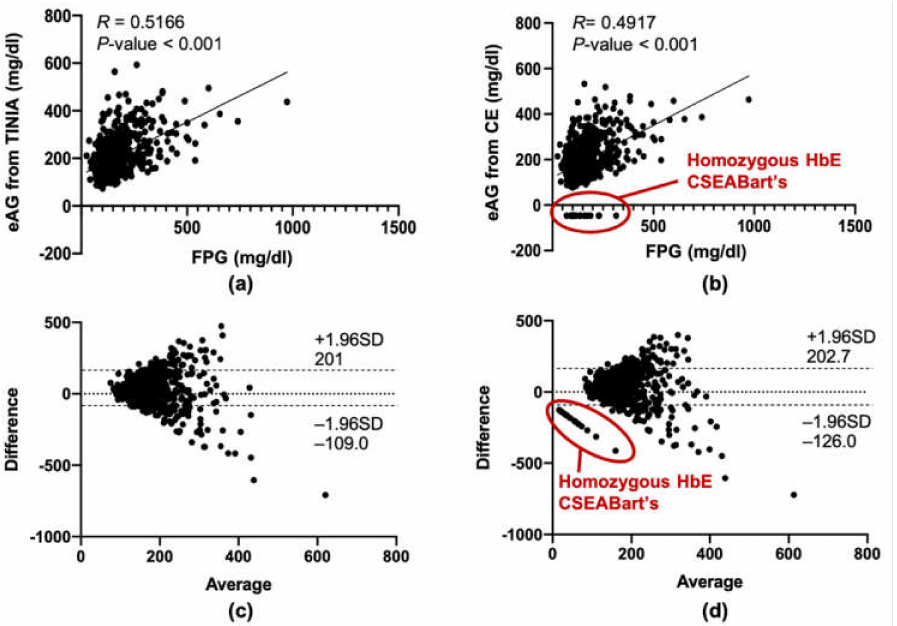
Figure 3. Correlation of fasting plasma glucose (FPG) and estimated average glucose (eAG) calculated from the HbA1c level obtained from TINIA and CE was analyzed using Pearson correlation ( a , b ) and Bland–Altman plot ( c , d ). X-axis is the mean between TINIA and CE (%). Y-axis is the mean between TINIA and CE (%). Dotted line represented 95%